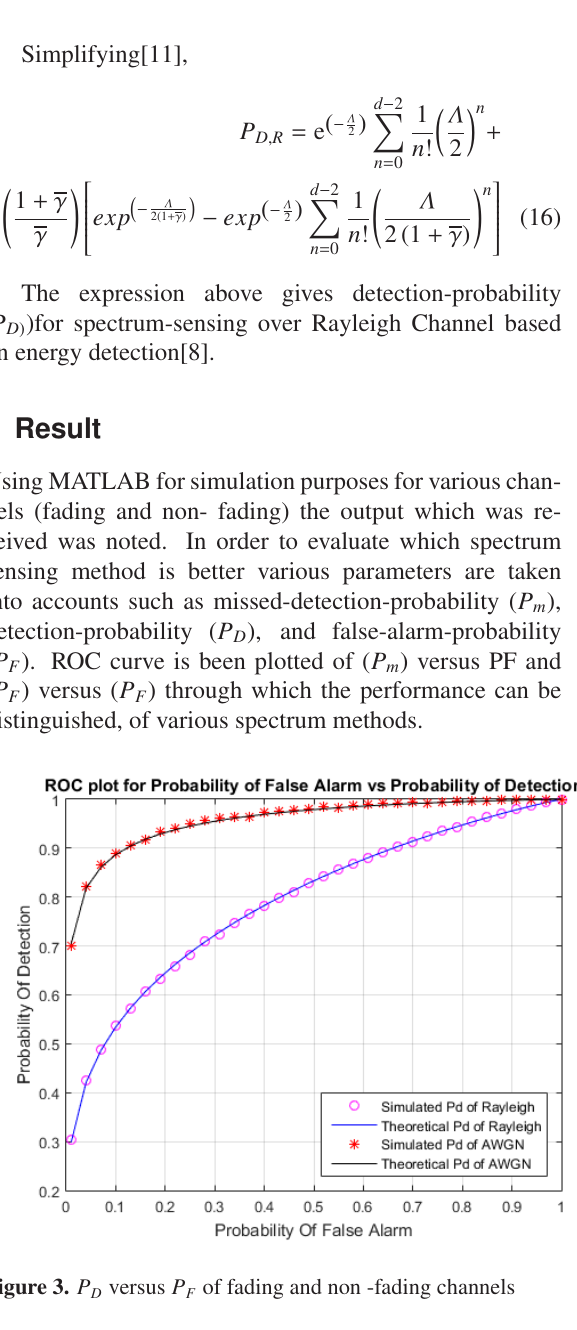
From the Figure 3 it is clear that the detection- probability (PD) of fading channel (Rayleigh) is less than the non-fading channel (AWGN). This graph clearly gives the idea that the usage of the spectrum band is less when the fading is taken into consideration. The results obtained after simulation and the theoretical ones are matched ap-